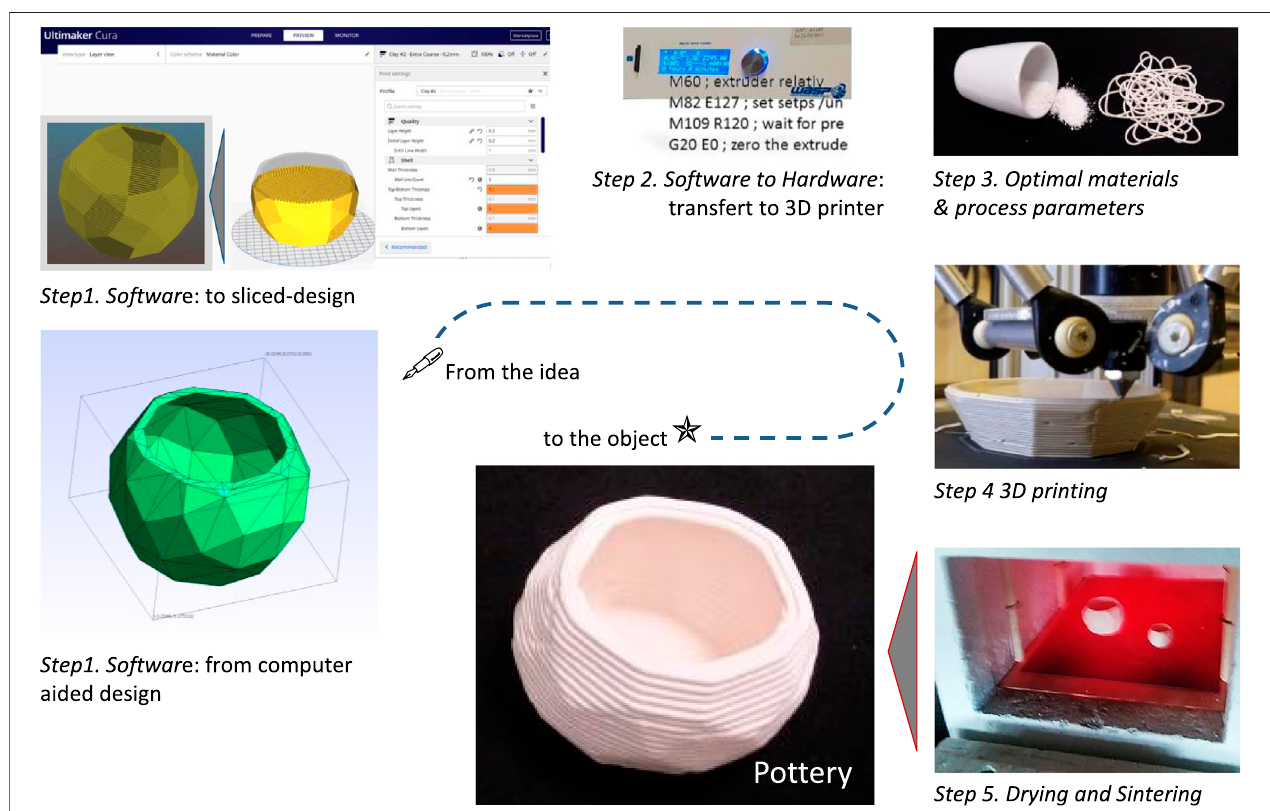
FIGURE 8 | From a CAD idea and using hydrated kaolinite to an artistic